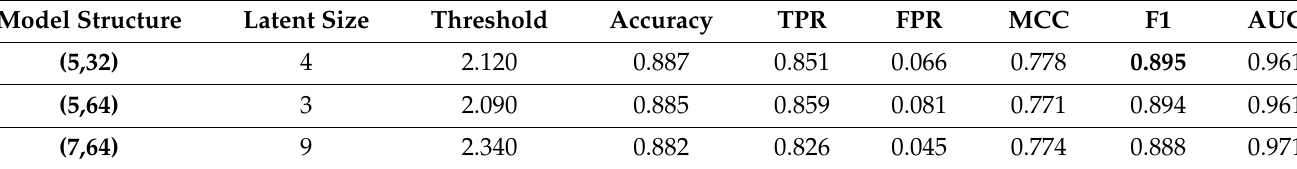
Table 6. The best performance for each model configuration. The best F1-score is in bold. Model